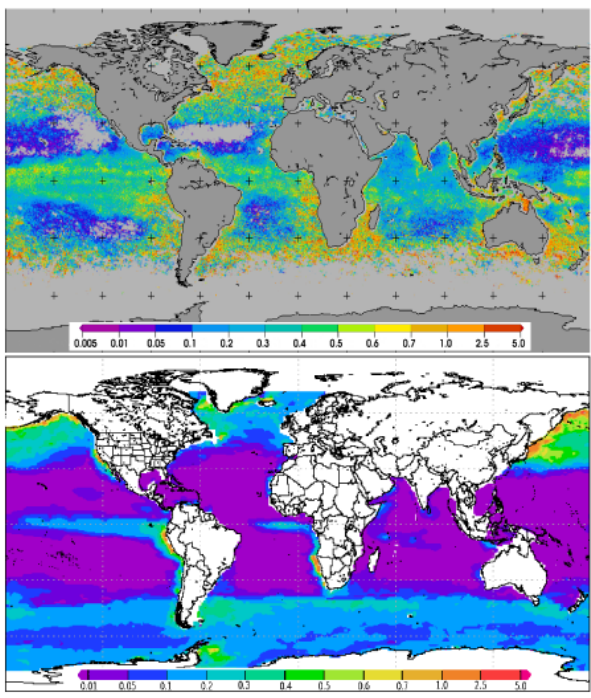
Fig. 10. Comparison of the PhytoDOAS retrieved chl a of diatoms [mgm − 3 ] (upper panel) with the NOBM modeled result of di- atom chl a [mgm − 3 ] (lower panel), both in the northern spring (April/May/June) 2005.